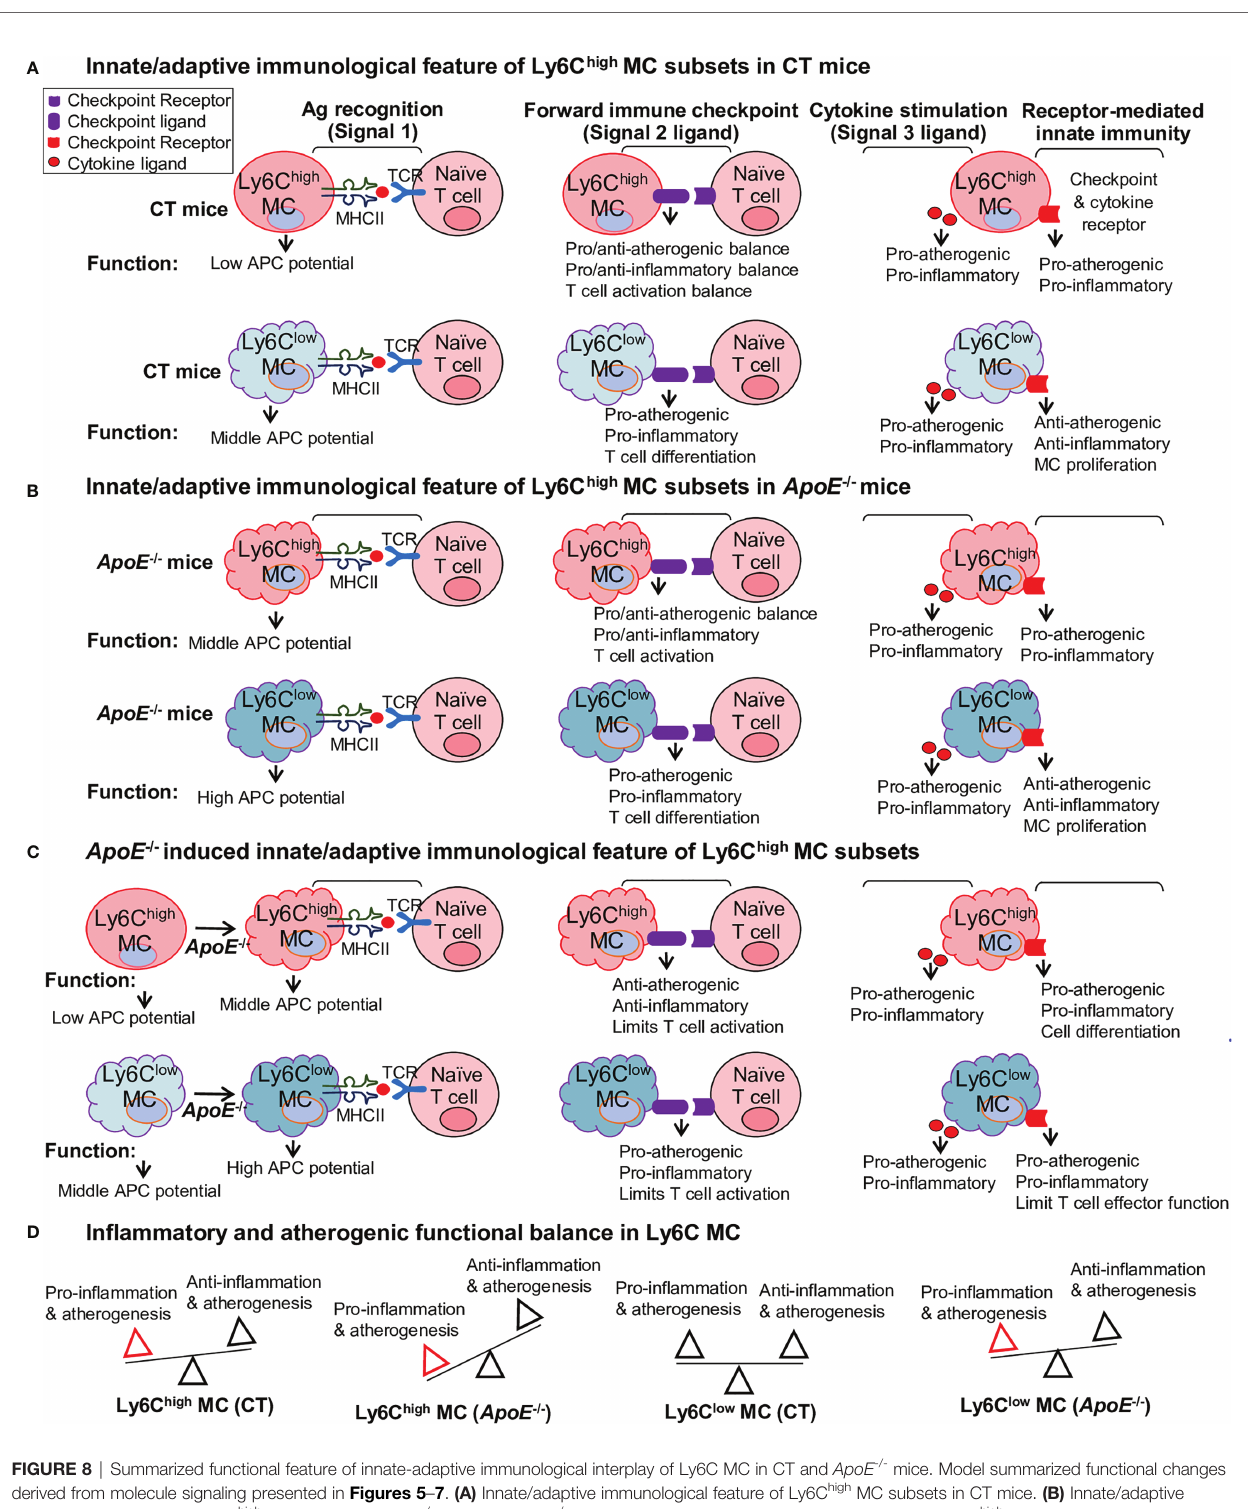
FIGURE 8 | Summarized functional feature of innate-adaptive immunological interplay of Ly6C MC in CT and ApoE -/- mice. Model summarized functional changes derived from molecule signaling presented in Figures 5 – 7 . (A) Innate/adaptive immunological feature of Ly6C high MC subsets in CT mice. (B) Innate/adaptive immunological feature of Ly6C high MC subsets in ApoE -/- mice. (C) ApoE -/ – induced innate/adaptive immunological feature of Ly6C high MC subsets. (D) In fl ammatory and atherogenic functional balance in Ly6C MC. APC, antigen presenting cell; TCR, T cell